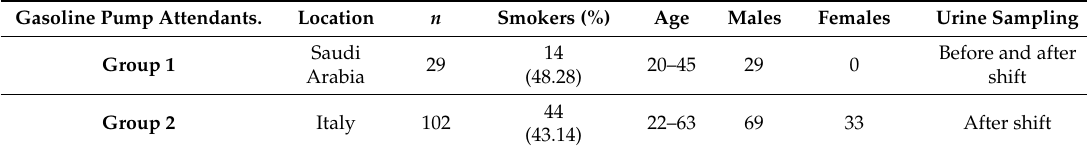
Table 1. Characteristics of the two groups